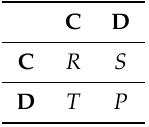
Table 1. Payoff matrix of a two-player game. C and D on the left column are Alice’s choices, while C and D on the top row are